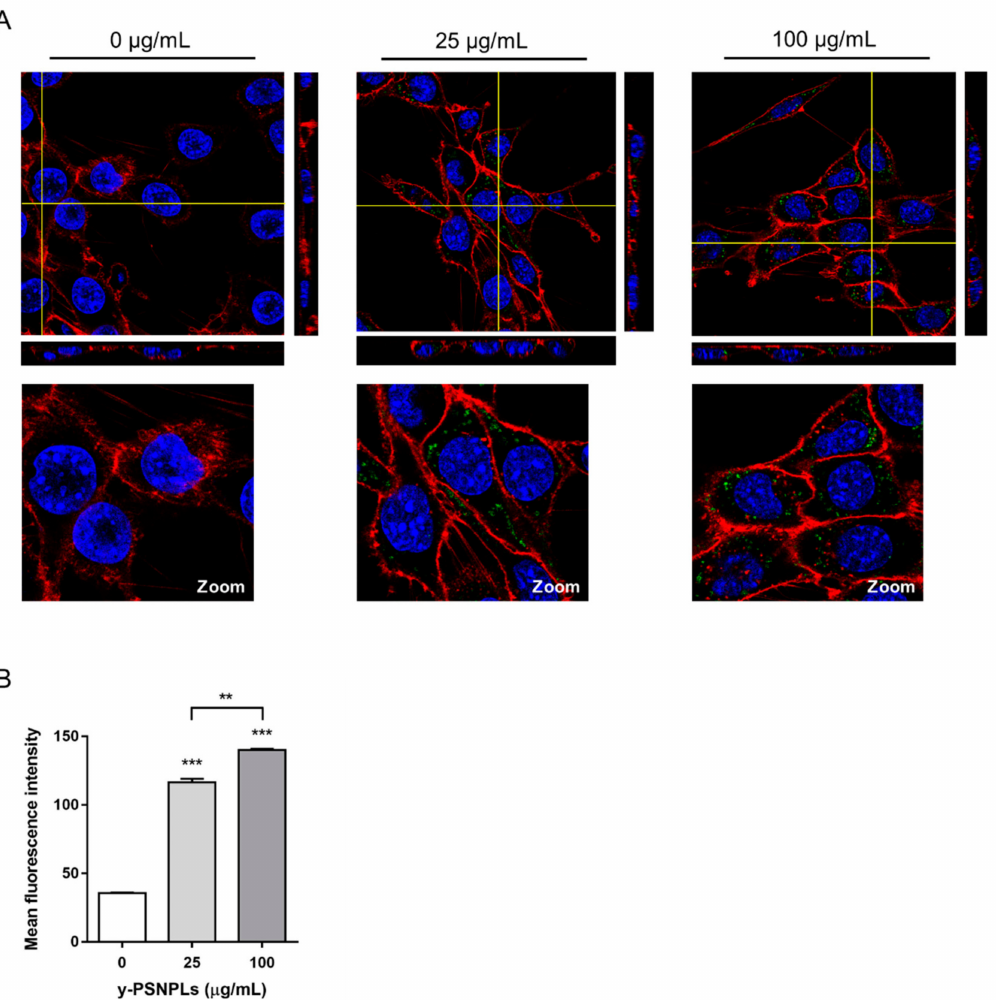
Figure 2. y-PSNPLs uptake by PTP cells. ( A ) Images of the PTP cells were taken with confocal microscopy after the exposure to 0, 25, and 100 µ g/mL y-PSNPLs for 24 h. Nuclei (showed in blue) were stained with Hoechst and cell membranes (showed in red) were stained with CellMask. y-PSNPLs are shown in green. Yellow lines point out the plane from where orthogonal views are projected. ( B ) y-PSNPLs intake by PTP cells after 24 h of exposure to 0, 25, and 100 µ g/mL. The mean fluorescence intensity of the living PTP cells’ total population is represented. Data are shown as mean ± SEM and analyzed by the Student’s t -test (*** p < 0.001, ** p < 0.01, compared to non-exposed PTP cells controls or other conditions as